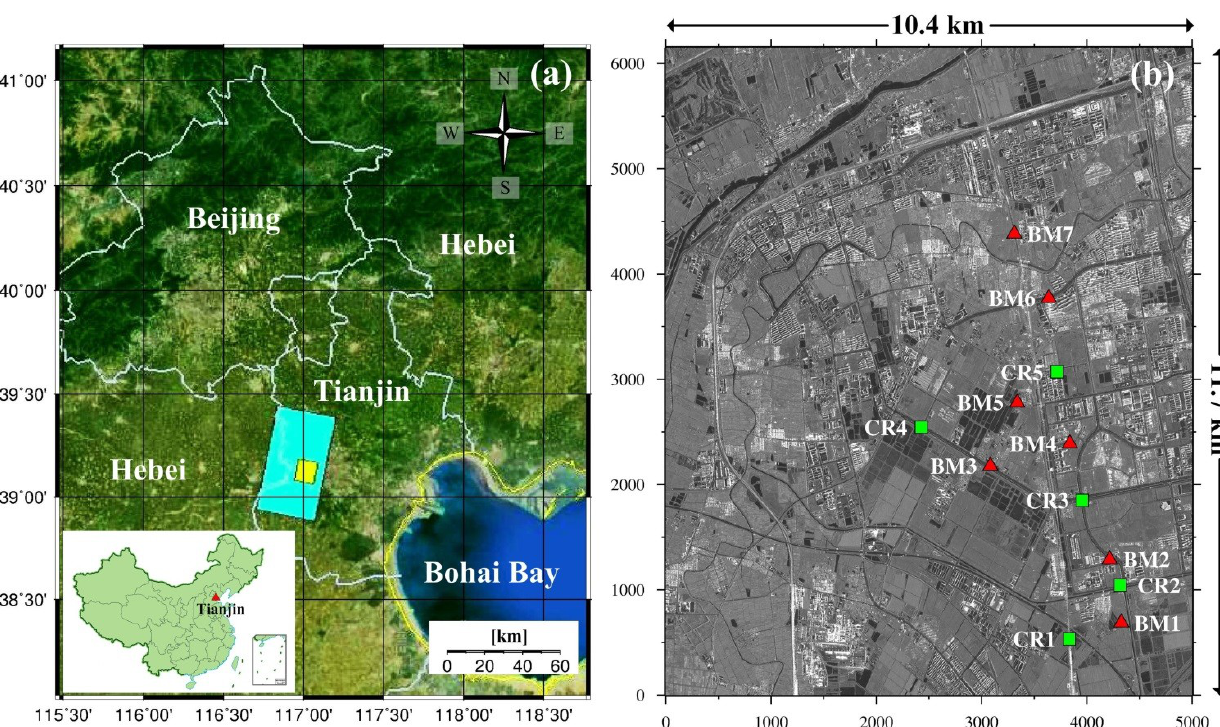
Figure 3. The location map and the study area around Tianjin in China. The coverage of the TSX scenes and the study area selected are marked in ( a ) by a larger and smaller filled rectangle, respectively. The amplitude image averaged from 40 TSX images of the study area is shown in ( b ) with the annotation of seven benchmarks (BMs) by red triangles and five corner reflectors (CRs) by green